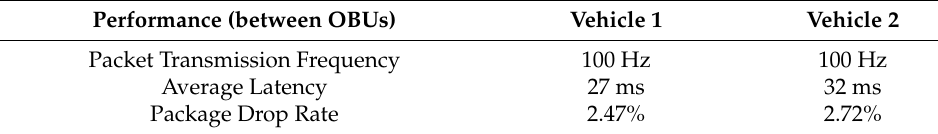
Figure 11. Vehicle2 Performance. Table 2. V2V Test